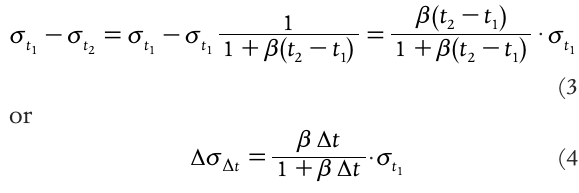
Figure 3. Graph of changing of temperature versus depth within the contour of Muradkhanly